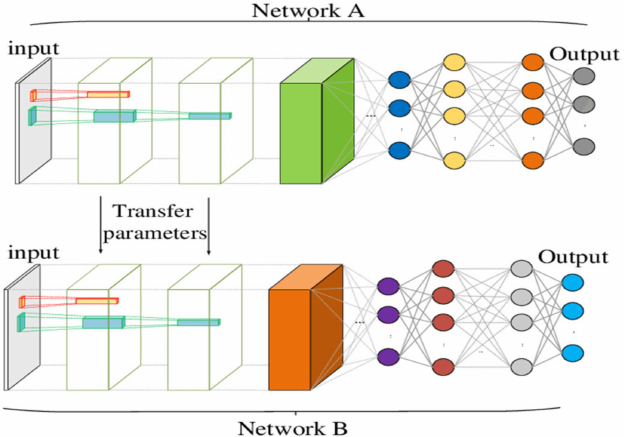
Figure 5. Demonstration of transfer learning technique where all layers in networks A and B are identical except for the output layer, which is tuned to fit the new classification